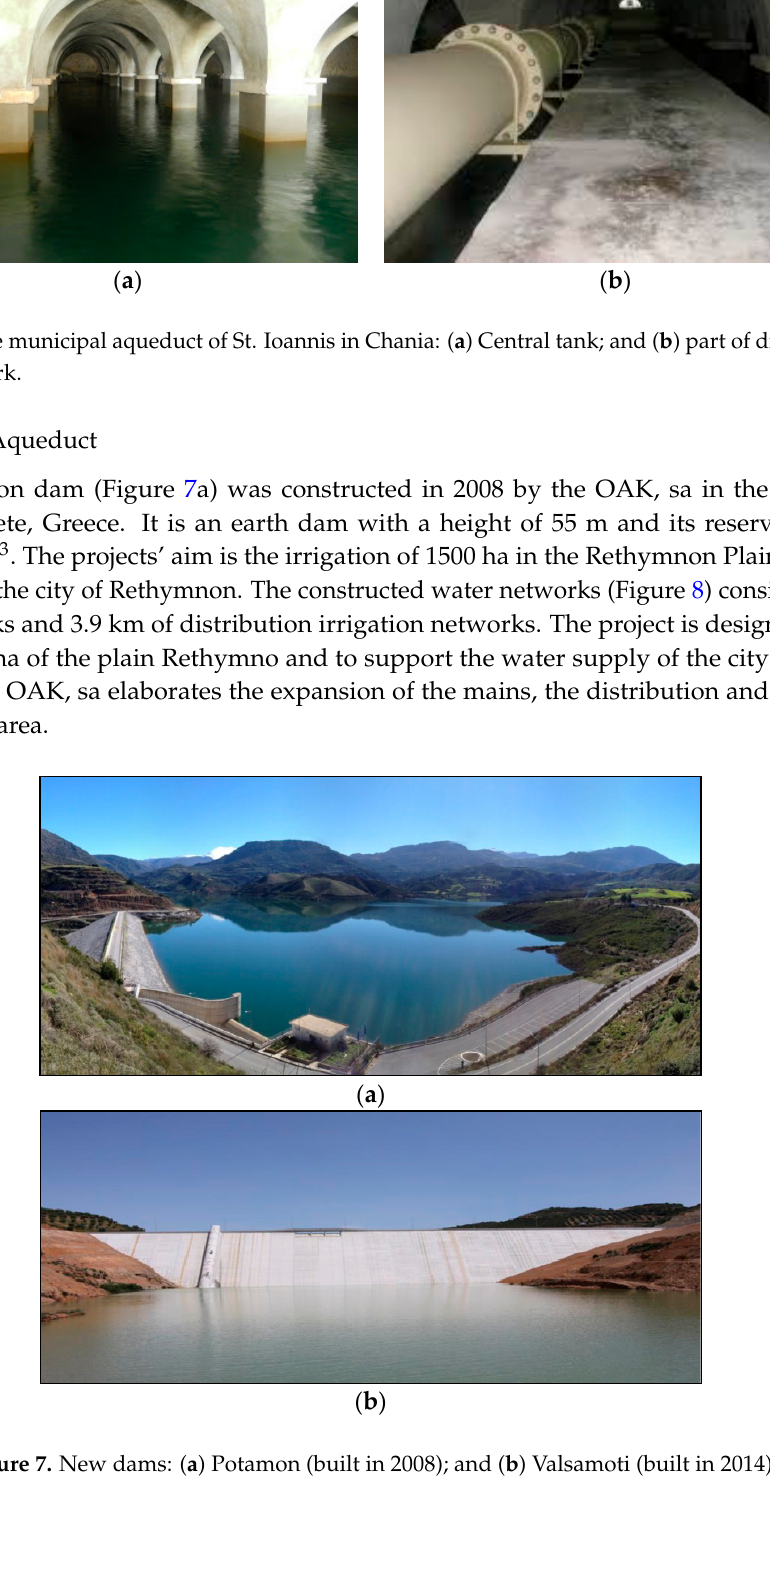
( a ) ( b ) Figure 8. OAK, sa’s water works network in the Prefectures of: ( a ) Chania; and ( b ) Rethymnon.